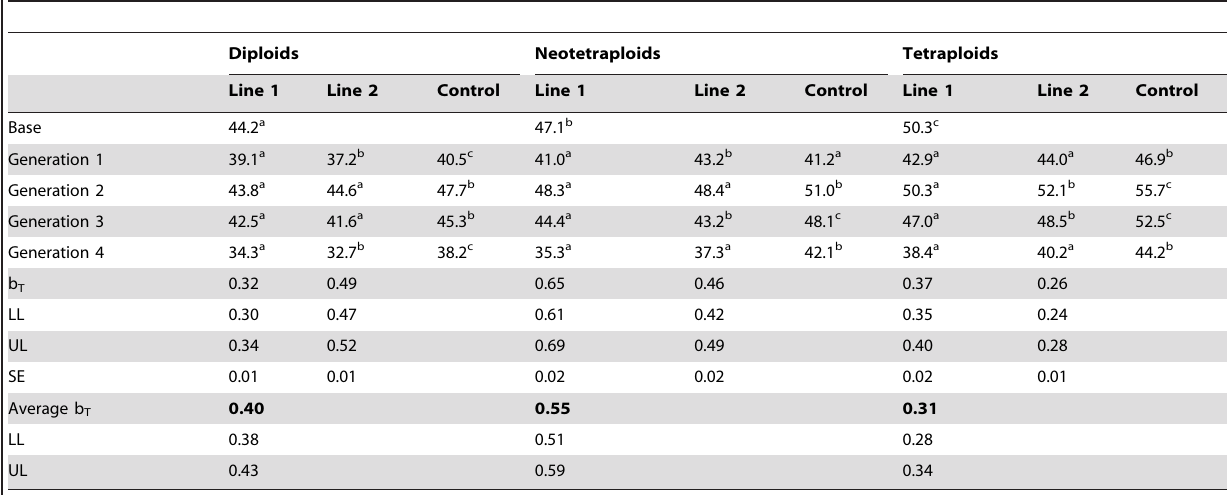
Table 3. Flowering time in days for each line across generations with realized heritability estimates ( ^ bb T ) with standard error and 95% confidence limits (standard error= SE, lower limit =LL, upper limit =UL) by line and averaged for each ploidy.